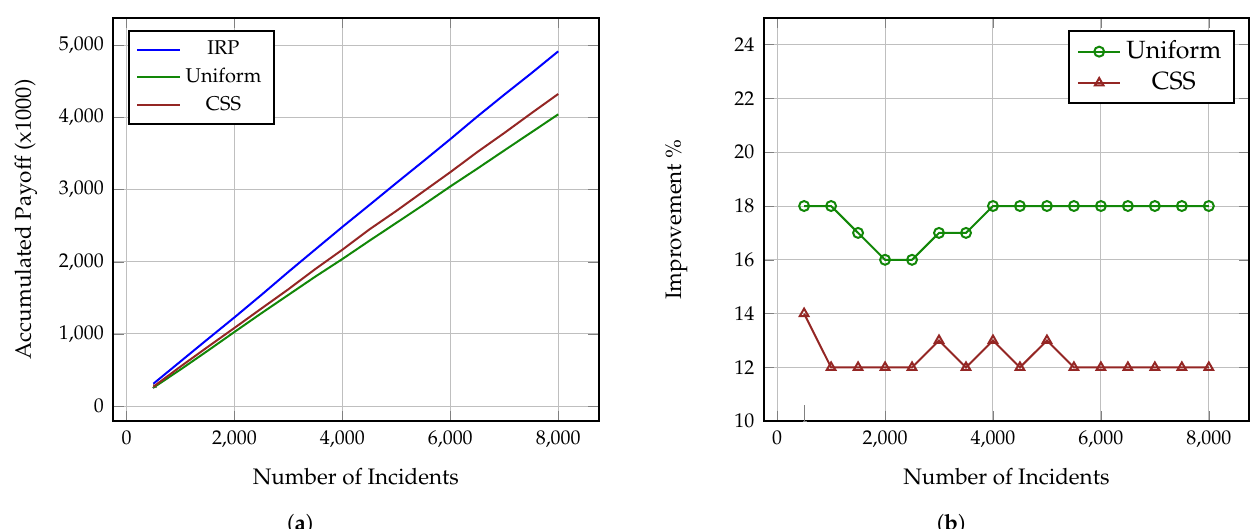
Figure 2. Performance comparison of IRP, Uniform and CSS on N = 8000 simulated incidents against Strategic Attacker. ( a ) Accumulated payoff, ( b ) Percentage of IRP improvement.